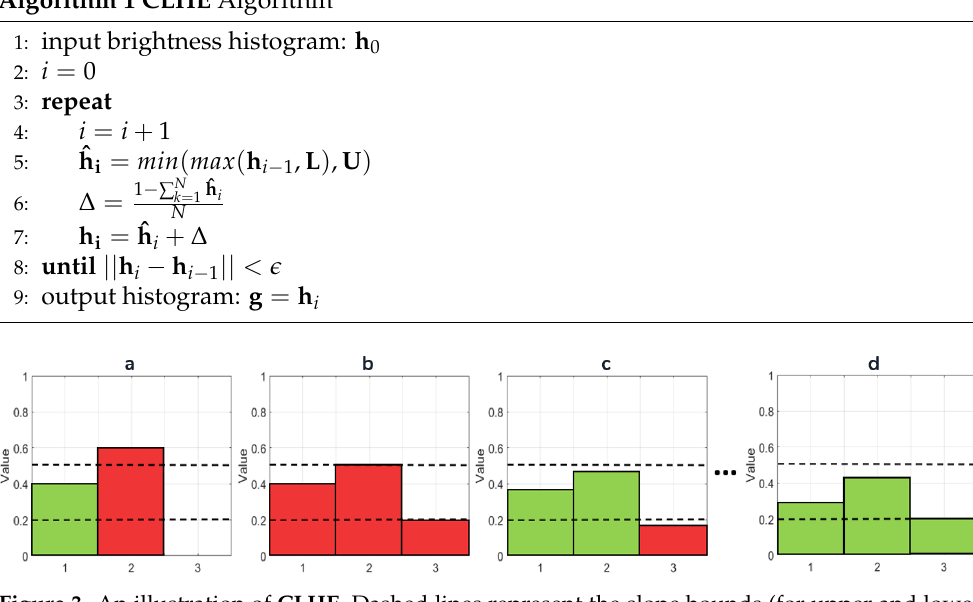
Figure 3. An illustration of CLHE . Dashed lines represent the slope bounds (for upper and lower slopes of 1.5 and 0.6). ( a ) Input histogram [0.4, 0.6, 0]. Sums to 1, but bins 2 and 3 do not obey slope constraints. ( b ) Histogram clipped to slope limits. All bins obey slope limit, but sum of histogram is 1.1, ∆ = − 0.1 ( c ) Histogram with ∆ evenly distributed ( − 0.33 to all bins). The result sums to 1, but bin 3 does not obey slope constraint and will be clipped again to 0.2. ( d ) Histogram after 5 clip and redistribution steps. Final values [0.35, 0.45, 0.2] satisfy slope bounds and sum to